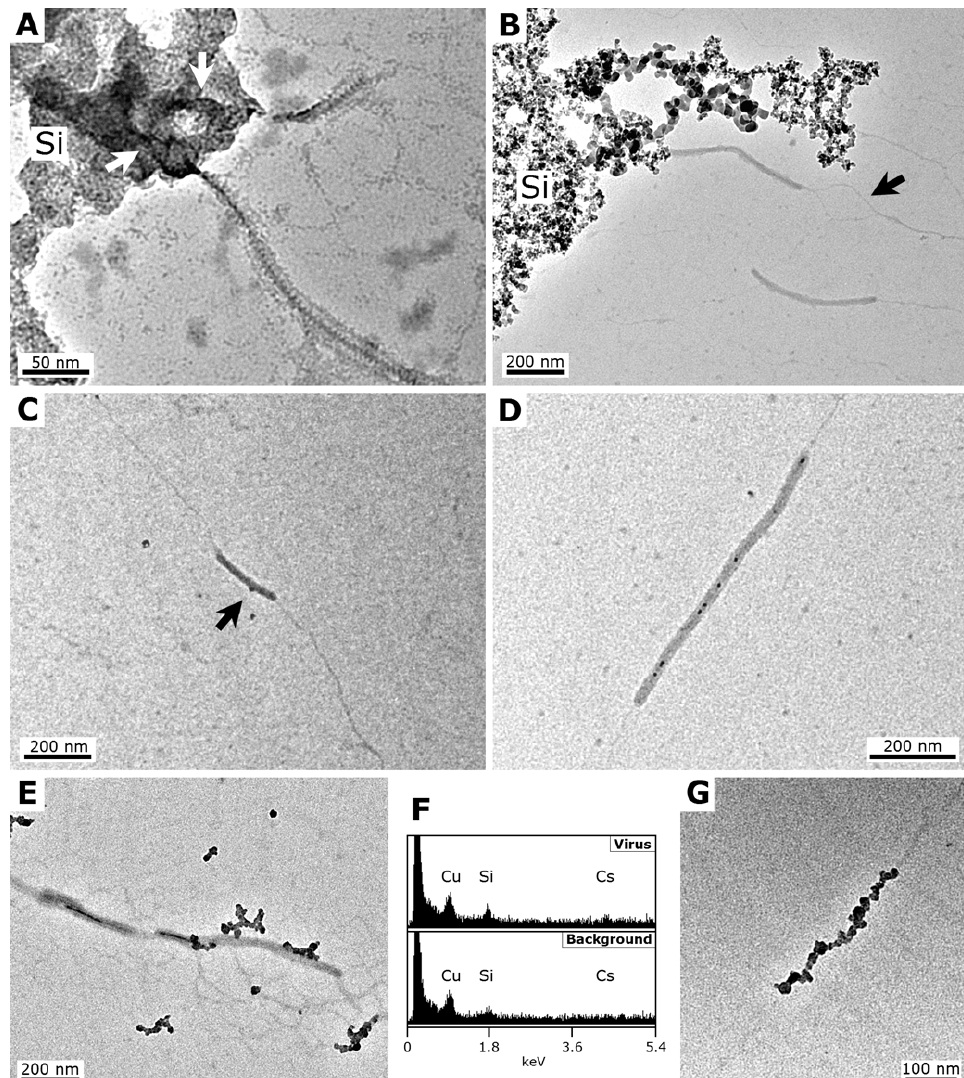
Fig. 2. TEM micrographs showing progressive steps of the experimental fossilisation of SIRV2 at a ∼ 160ppmSi silica concentration. (A) 48h, SIRV2 particle partially trapped inside the silica precipitate (Si); the arrows underline the shape of the virion inside the precipitate. (B) 7days, fragments of SIRV2 particles in the vicinity of a silica precipitate (Si); the two separated filaments of viral DNA-protein are visible (arrow). (C) 7days, unstained grid, fragment of SIRV2 particle; a dark ∼ 10nm particle is seen attached on the virion (arrow). (D) 30days, SIRV2 particle; note the numerous dark silica particles in the central cavity. (E) 60days, unstained grid, fragments of SIRV2 particle; note the dark silica particles attached on the outer surface of the virion, and filling the central cavity. (F) 60days, EDX spectra made on the SIRV2 particles of (E) , showing a Si signal slightly higher than on the background; the Cs signal comes from the cesium chloride used for virus purification and the Cu signal comes from the copper grid. (G) 60days, unstrained grid, viral DNA-protein filament covered by silica particles. All TEM micrographs were made at 200kV on grids negatively stained with uranyl acetate, unless otherwise